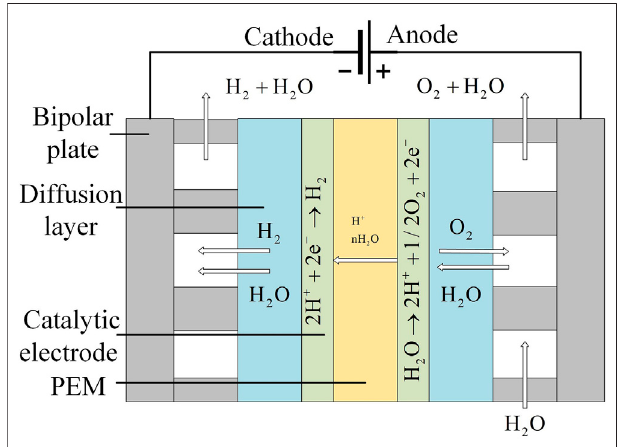
FIGURE 2 | Schematic diagram of PEMEC ’ s single electrolytic chamber reaction